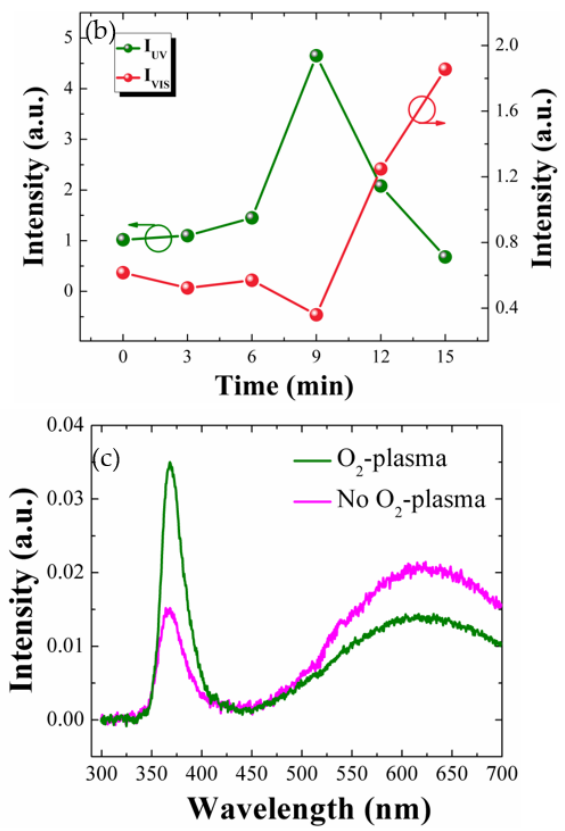
Figure 2. ( a ) RT PL spectra of ZnO NRs grown on SLs plasma-treated for different time intervals; ( b ) I UV and I VIS as a function of time measured from NRs grown on (0, 3, 6, 9, 12, 15 min) O 2 -plasma-treated SLs; ( c ) RT PL spectra of SLs (as-coated and O 2 -plasma-treated for 9 min).